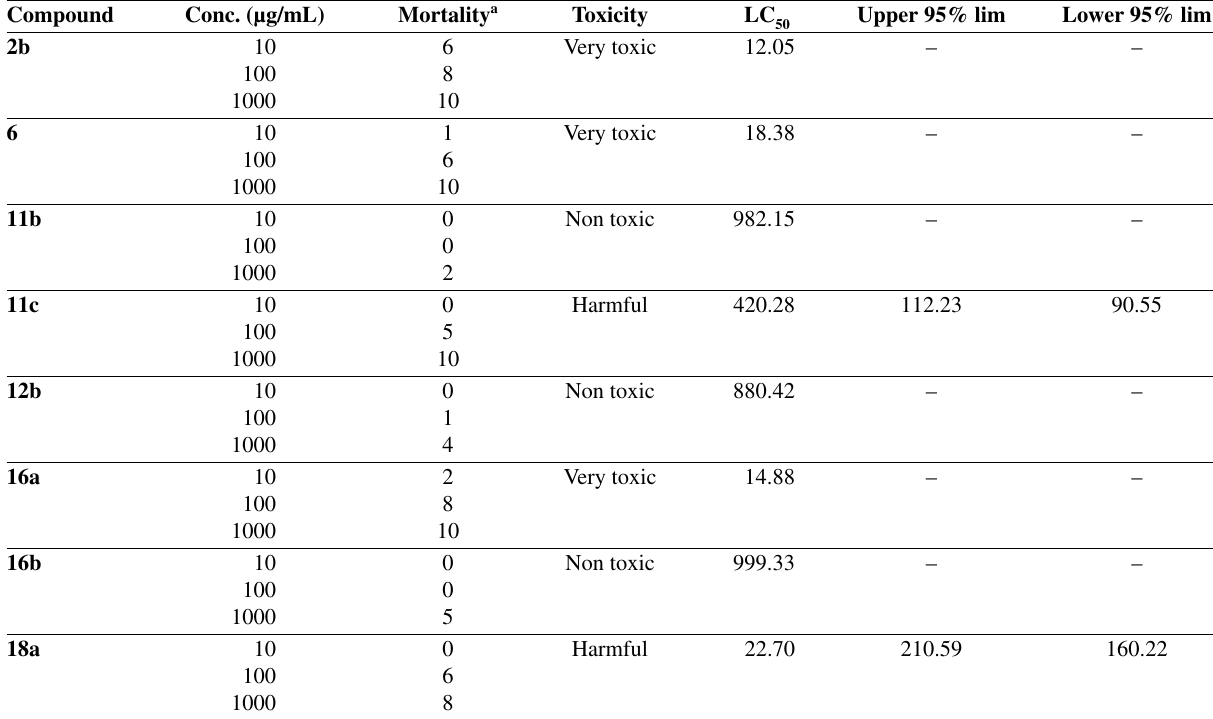
Table 2. Toxicity of the most potent compounds against the cancer cell lines Compound Conc. (μg/mL) Mortality a